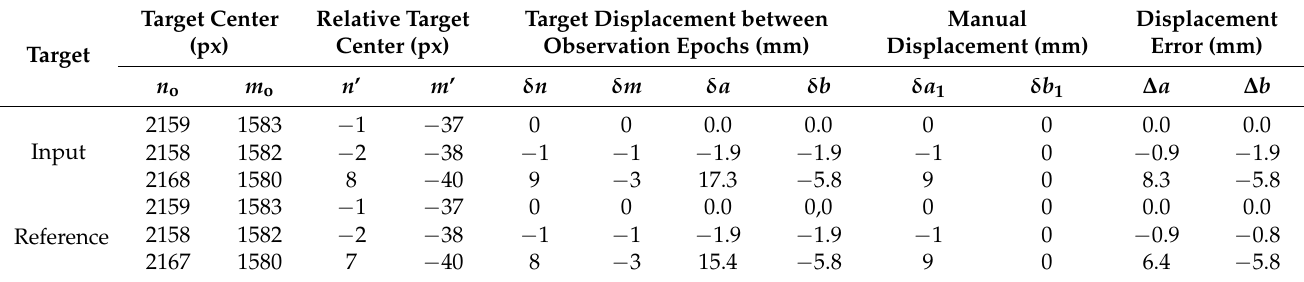
Table 4. Displacement determination for QR target at distance S = 33 m.